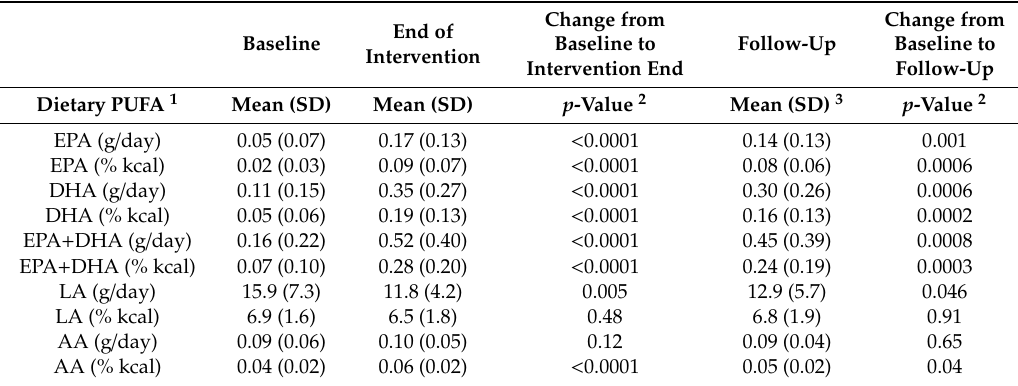
Table 1. Self-reported intake of dietary polyunsaturated fatty acids (PUFA) in fourteen post-menopausal women completing the LASO-3